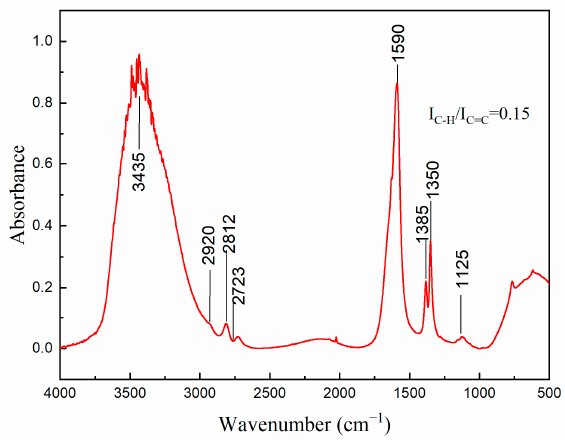
Figure 10. FTIR spectrum of GDI PM.